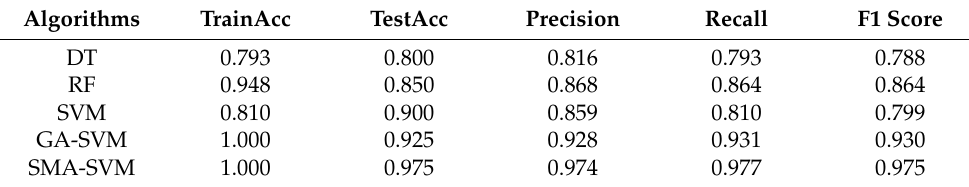
Table 3. Results of model